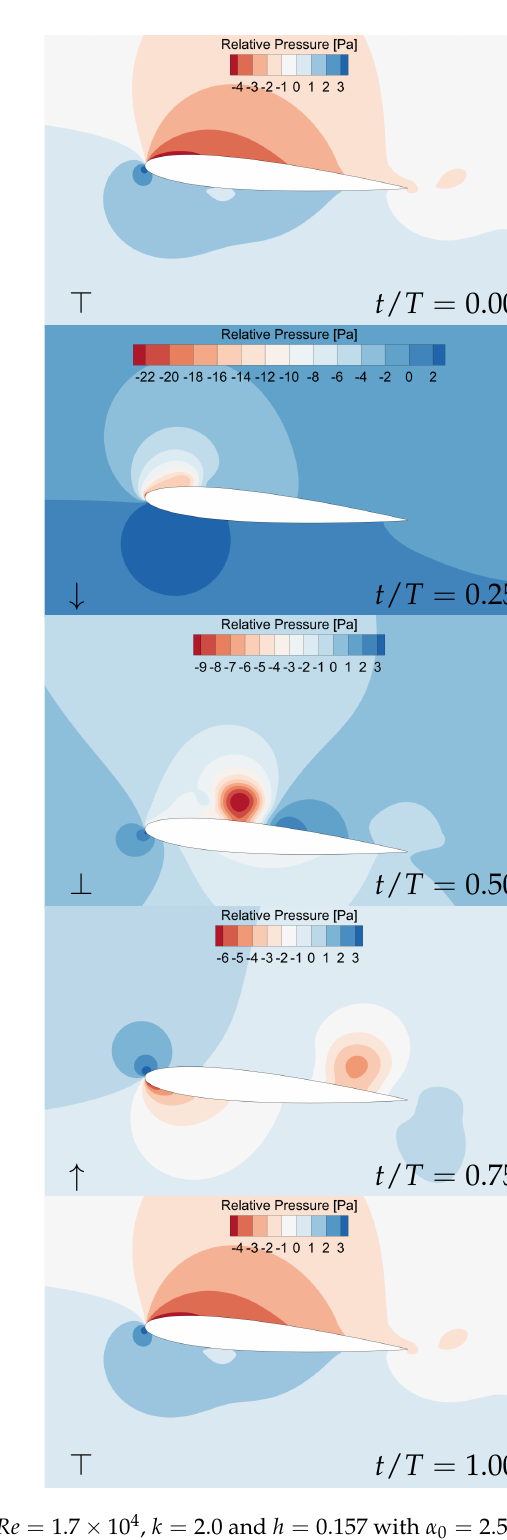
Figure 18. Relative pressure distribution over a period at Re = 1.7 Figure 17. Relative pressure distribution over a period at Re = 1.7 α 0 = 5.0 ◦ (right). α 0 = 5.0 ◦ ( right